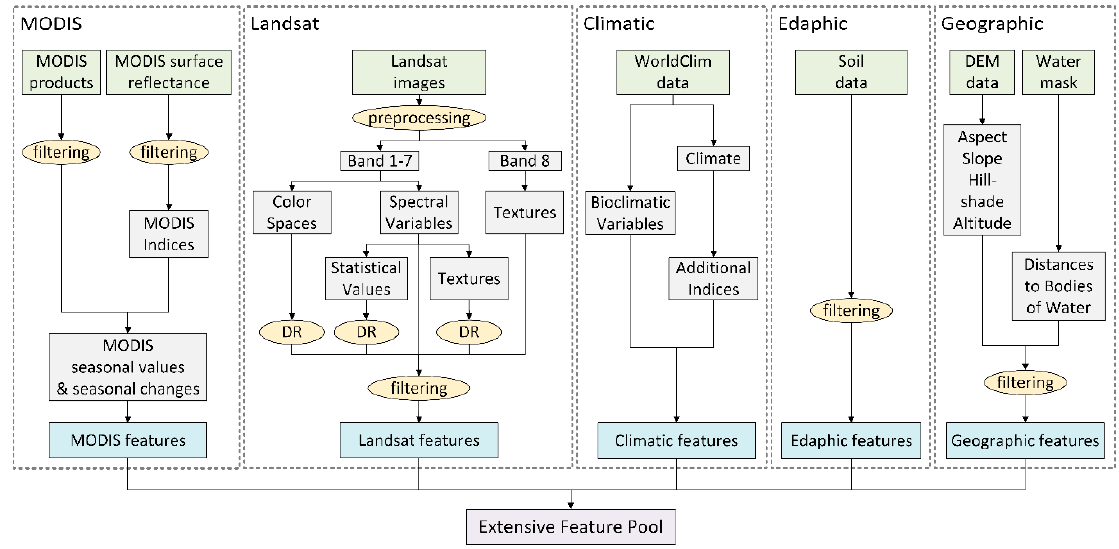
Figure 2. Extensive feature pool processing and computing procedures.